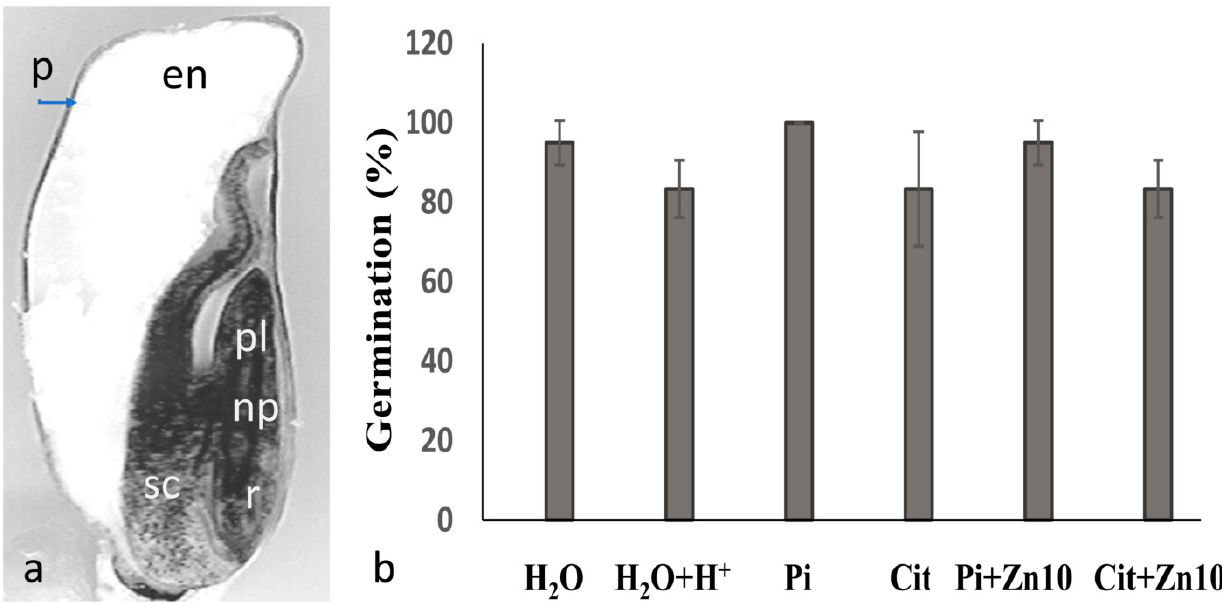
Figure 1. Grain structure and effect of zinc on germination. ( a ). Structure of maize grain. ( b ). Germination was determined in maize embryos imbibed for 24 h in the dark at a temperature of 25 °C in double-distilled water at a pH of 6.8 (H 2 O), double-distilled water at a pH of 4.5 (H 2 O+H + ), 10 mM of potassium phosphate buffer at a pH of 4.5 (Pi), 10 mM of sodium citrate buffer at a pH of 4.5 (Cit), or Pi or Cit buffer with ZnCl 2 at concentrations of 1 mM (Zn1), 10 mM (Zn10). The data represent the mean ± SE of n = 40 to 60 independent data points. ANOVA was performed, followed by the Tukey–Kramer multiple comparison test, with p < 0.05 representing significance. There was no significant effect on the percentage of germination among the experimental conditions shown. Symbols: en, endosperm, np, nodal plate; p, pericarp, pl, plumule; r, radicle.